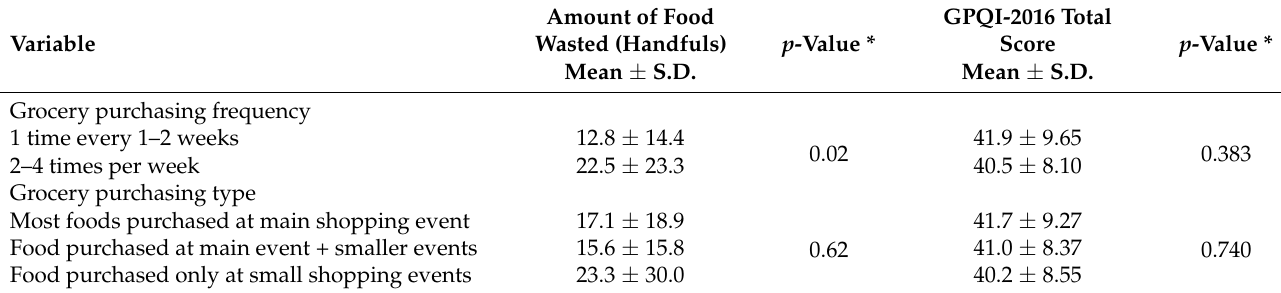
Table 6. Comparison of total amount of food wasted or diet quality of foods purchased (GPQI-2016 total score) by grocery purchasing